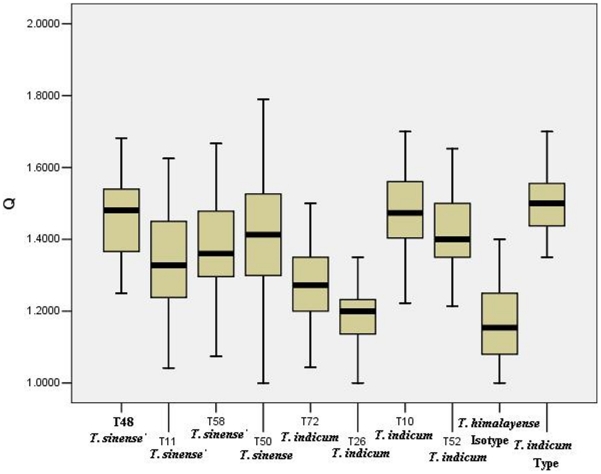
Box plot of length/width ratio (Q) of an ascospore.Box plot illustrate the medians, upper and lower quartiles, range and extreme values. 5–7 fruit bodies and 300 measurements of each typical specimens of T. indicum. One fruit body of T. indicum holotype (100 measurements) and half fruit body of T. himalayense isotype (100 measurements).